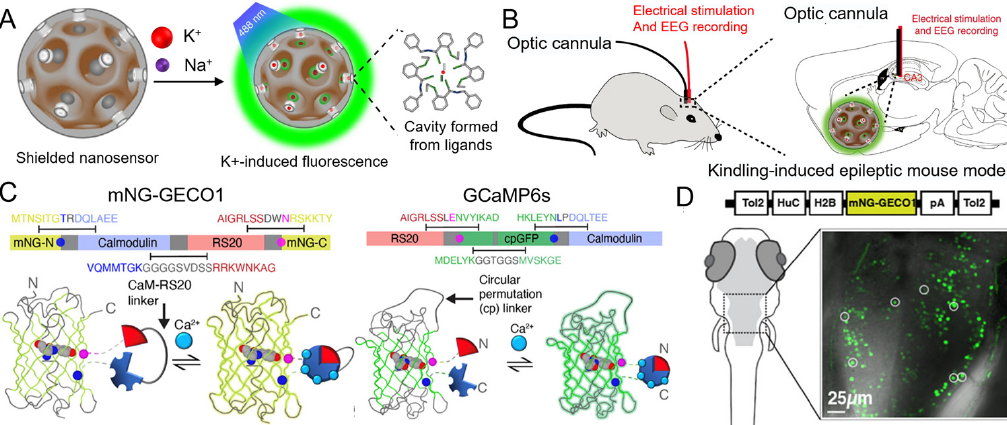
Figure 11. Two representative examples of essential metal ion detection in vivo: ( A ) Schematic showing the design of the K + nanosensor. ( B ) In vivo experimental scheme for K + sensing in a kindling-induced epileptic mouse model. Reproduced from [164] with permission from Springer Nature, copyright 2020. ( C ) Topology and in vitro characterization of mNG-GECO1 and GCaMP6s. ( D ) Schematic representation of the Tol2[HuC-H2B-mNG-GECO1] construct and confocal image of one fish (5–6 days post fertilization) with 7 regions of interest (ROI) circled. Reproduced from [167] with permission from the American Chemical Society, copyright 2020.